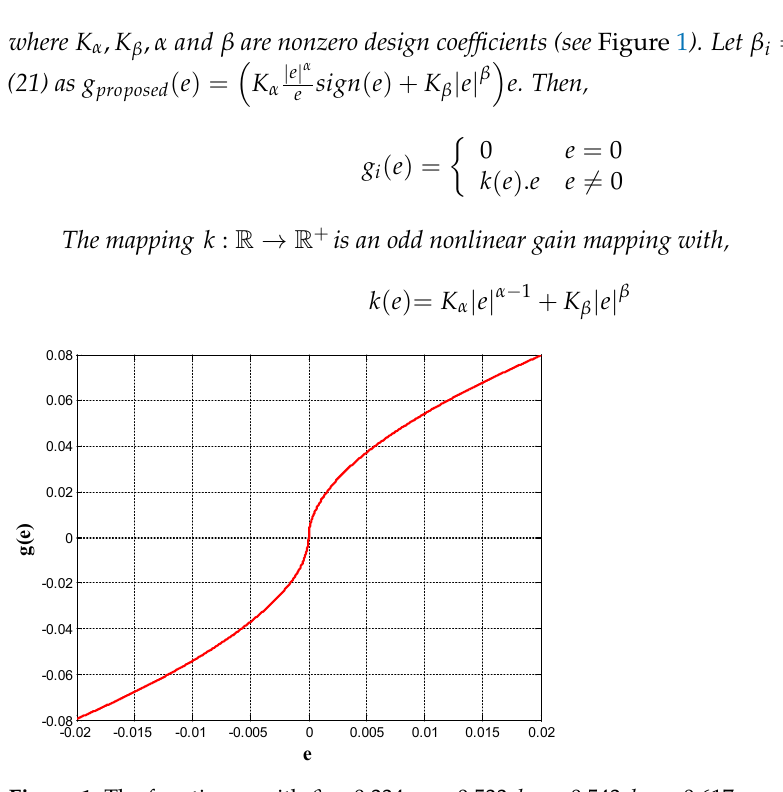
Figure 1. The function